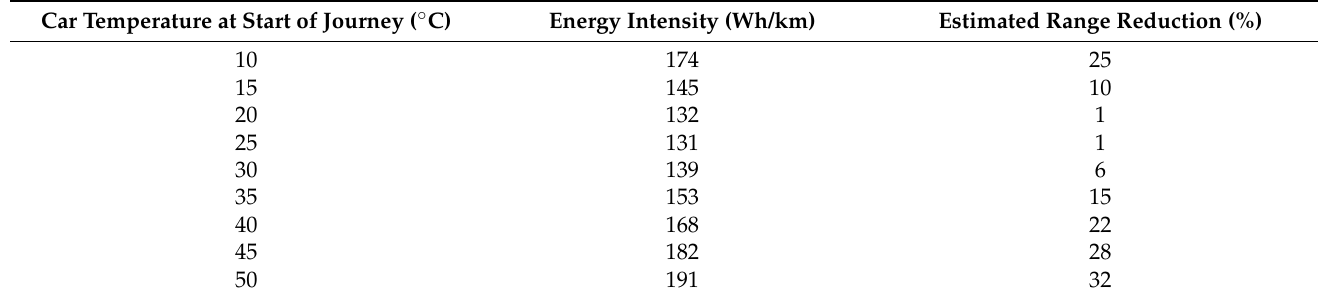
Table 5. Modelled in-use energy intensity and range reduction by car temperature at start of journey. Car Temperature at Start of Journey ( ◦ C) Energy Intensity (Wh/km) Estimated Range Reduction